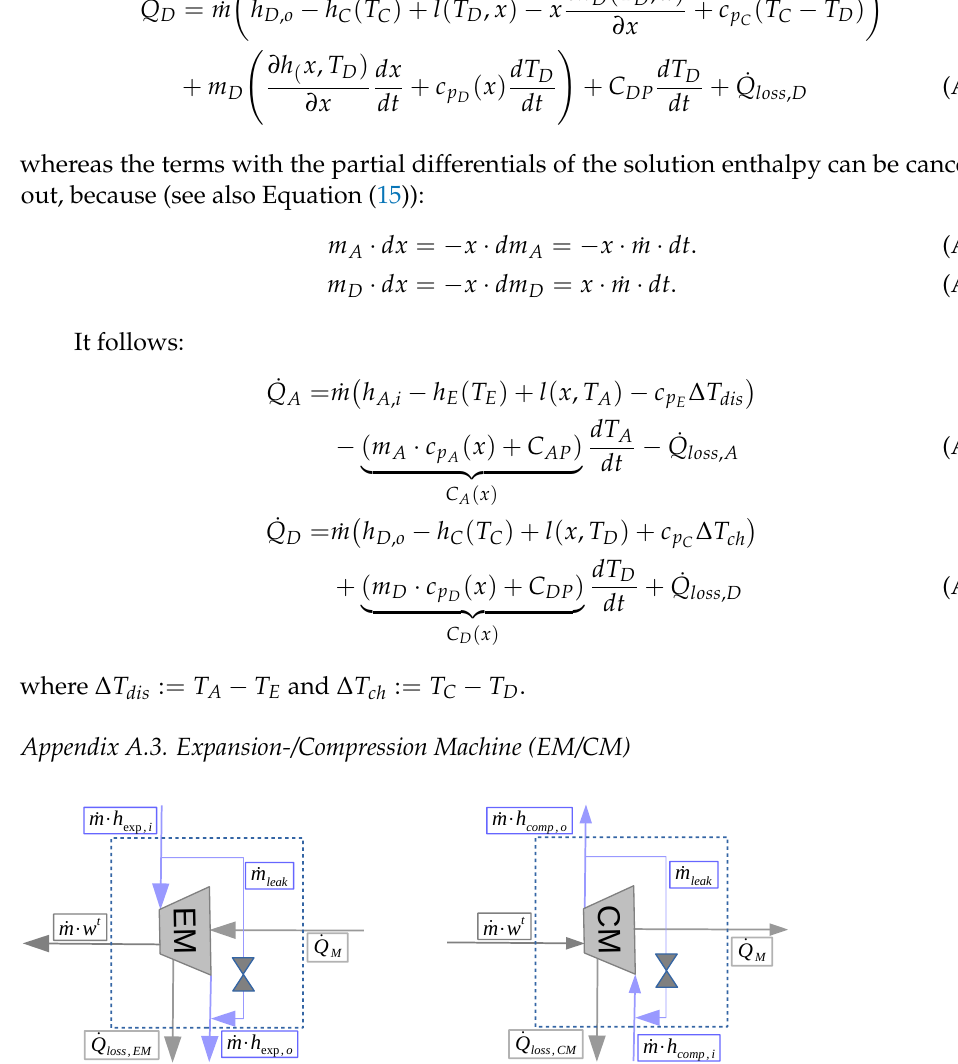
Figure A4. Energy balance of expansion device ( left ) and compression device ( right